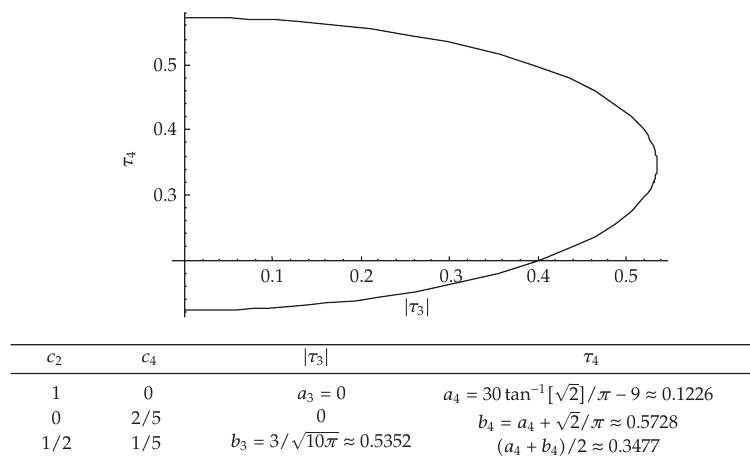
Figure 4: Boundary region and values of L- skew | τ 3 | and L- kurtosis τ 4 for third-order standard normal power method pdfs. For asymmetric distributions, valid pdfs exist in the region inside the graphed boundary. For symmetric distributions, valid pdfs exist for τ 4 between a 4 < τ 4 < b 4 . The lower boundary point (cid:2) a 3 , 4 (cid:3) denotes the normal distribution. Note that a 3 and a 4 are lower limits and b 3 and b 4 are upper